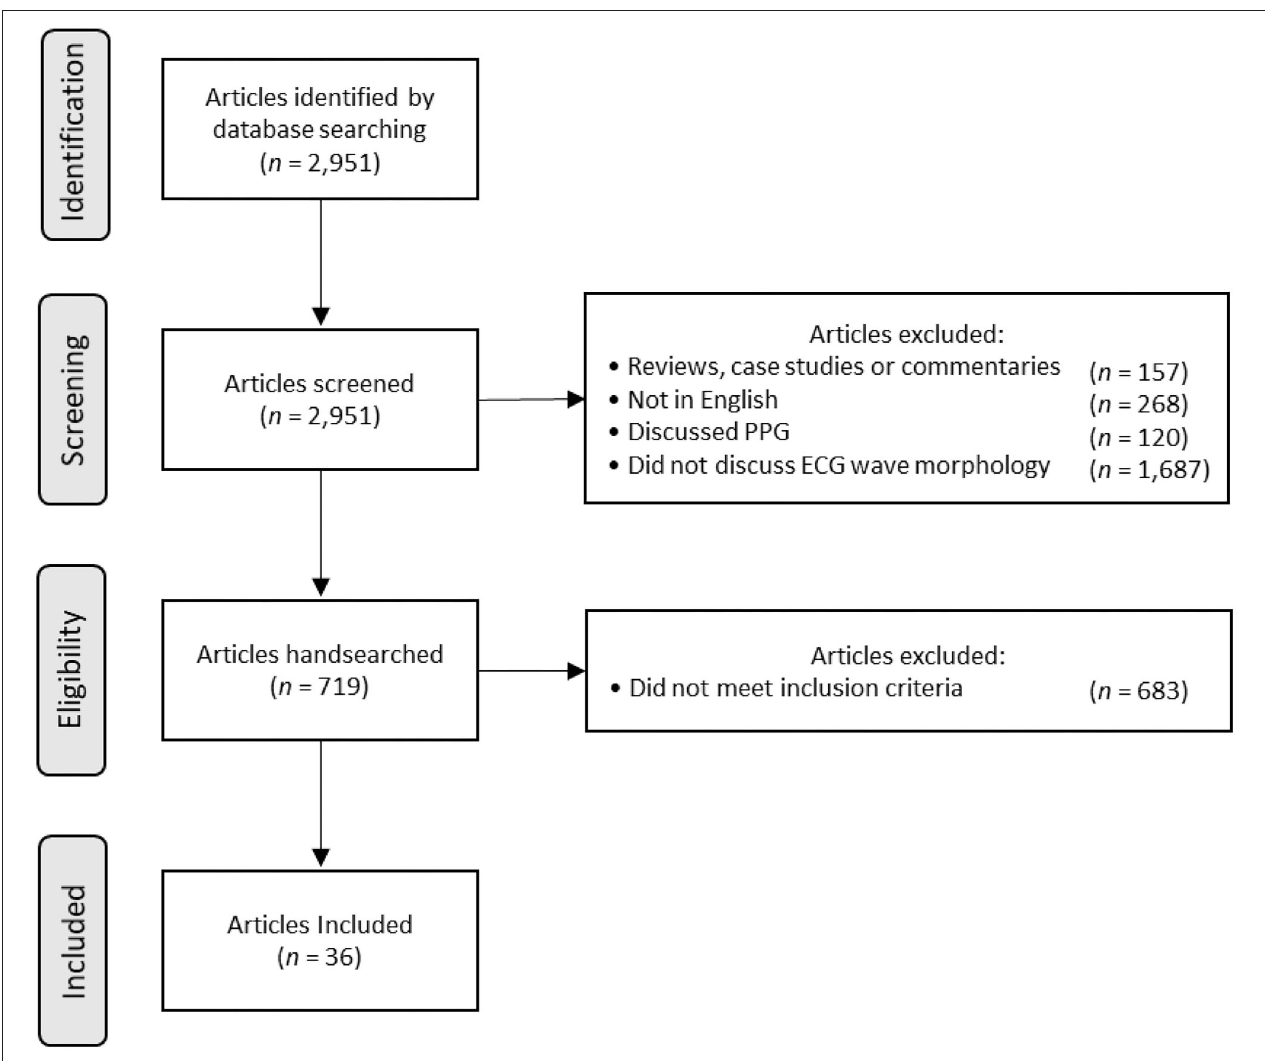
FIGURE 1 | Flowchart of the article search, screening, and selection